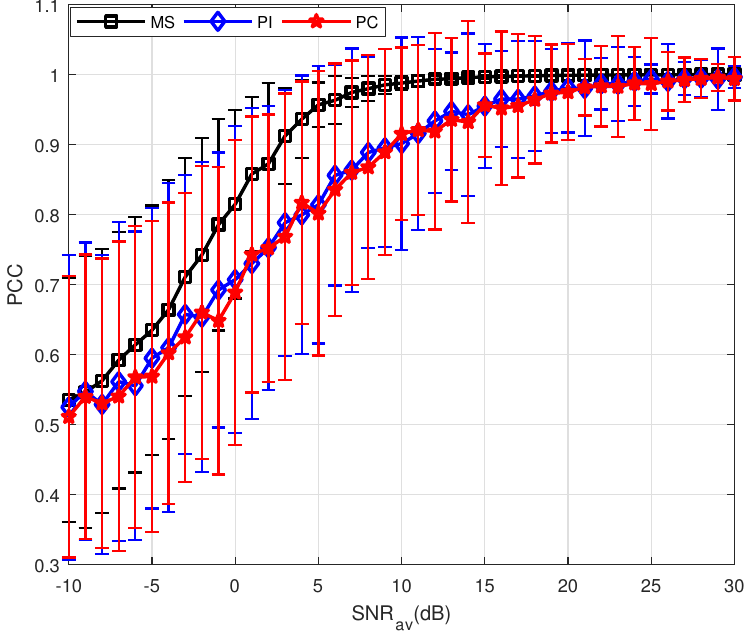
Figure 3. Results of three PSM estimation methods where P =